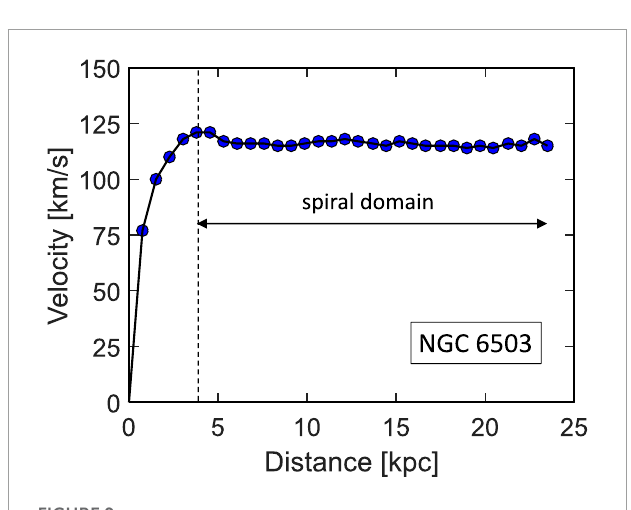
FIGURE 9 Rotation curve for the NGC 6503 Galaxy. The spiral domain covering distances greater than 4 kpc is indicated. In this domain, receding of spirals from the galaxy centre causes the flatness of the rotation curve. For data, see Begeman (1987) and Lelli et al.